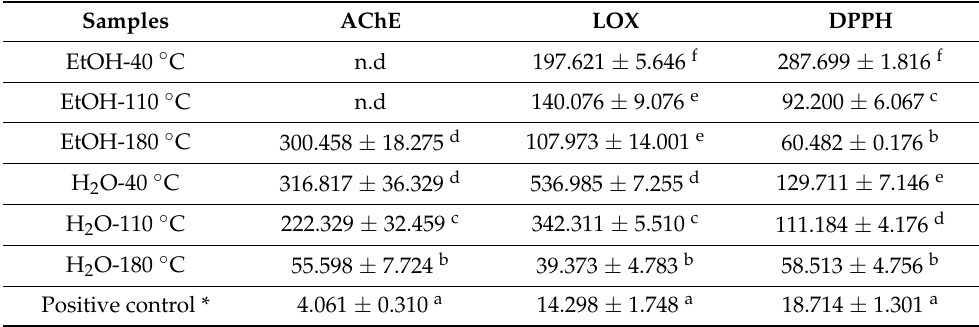
Table 1. IC50 ( µ g/mL) values from in vitro assays of different Ammodaucus leucotrichus extracts using AChE, LOX, DPPH